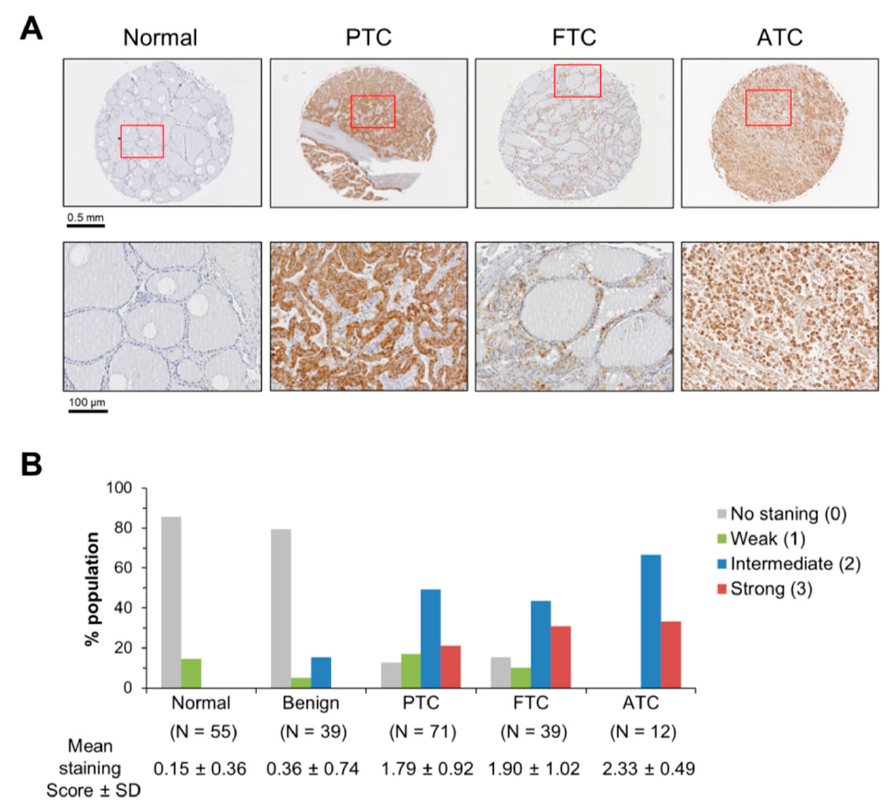
Figure 1. Mortalin is upregulated in human thyroid cancer. ( A ) Representative immunohistochemical analysis images of mortalin protein in normal thyroid, papillary thyroid carcinoma (PTC), follicular thyroid carcinoma (FTC), and anaplastic thyroid carcinoma (ATC). ( B ) Scores of mortalin expression in patient tissue biopsy specimens. p > 0.05 for benign tumor vs. normal; p < 0.001 for PTC vs. normal; p < 0.001 for FTC vs. normal; p < 0.001 for ATC vs. normal, Kruskal–Wallis test (nonparametric ANOVA) with Dunn post-test for multiple comparison.